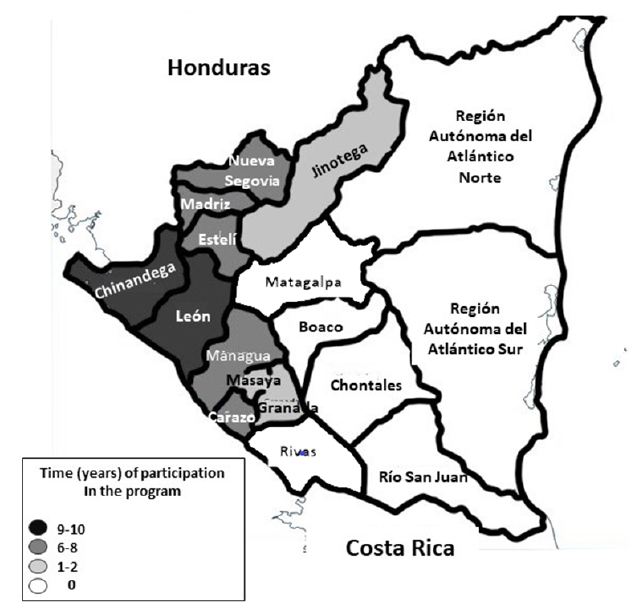
Figure 1. Time of participation of the Nicaraguan Departments in the Newborn Screening Program for CH. The national map reflects in shades of light grey, dark grey and black the 10 provinces departments (out of 17 in the country) which participated in the program at any time between 2005 and 2015